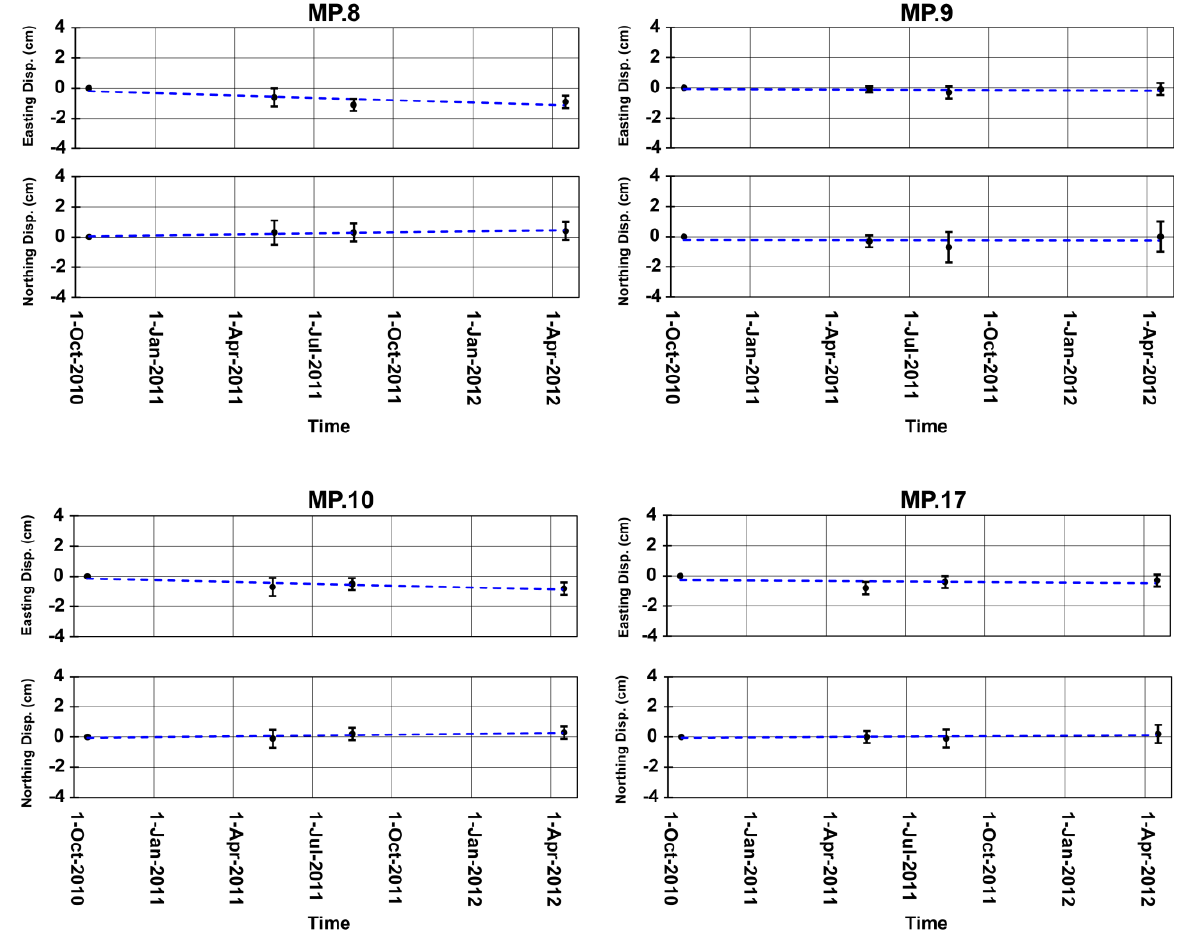
Figure 12. Four samples of GPS results with 95% error bars; for the location of points please see Figure 11. The solid circles represent displacement values, and the dashed blue line is a one-dimensional polynomial trend fitted to the displacement